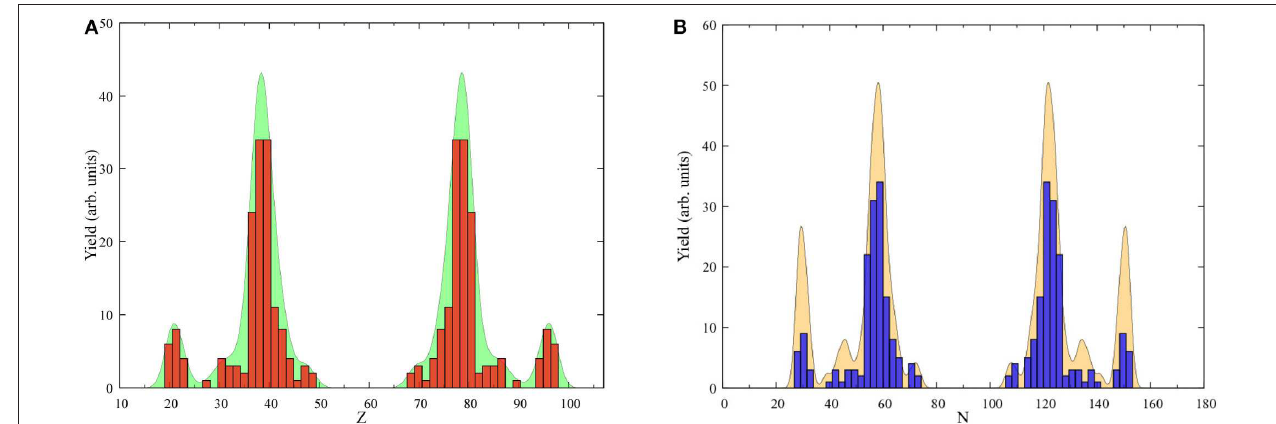
FIGURE 4 | (A) Fragment charge yield (histogram) and (B) Neutron yields for the reaction 48 Ca + 249 Bk at E c.m. = 234 MeV. The smooth representations of the histograms are obtained by using a kernel density estimation with bandwidth 0.012.